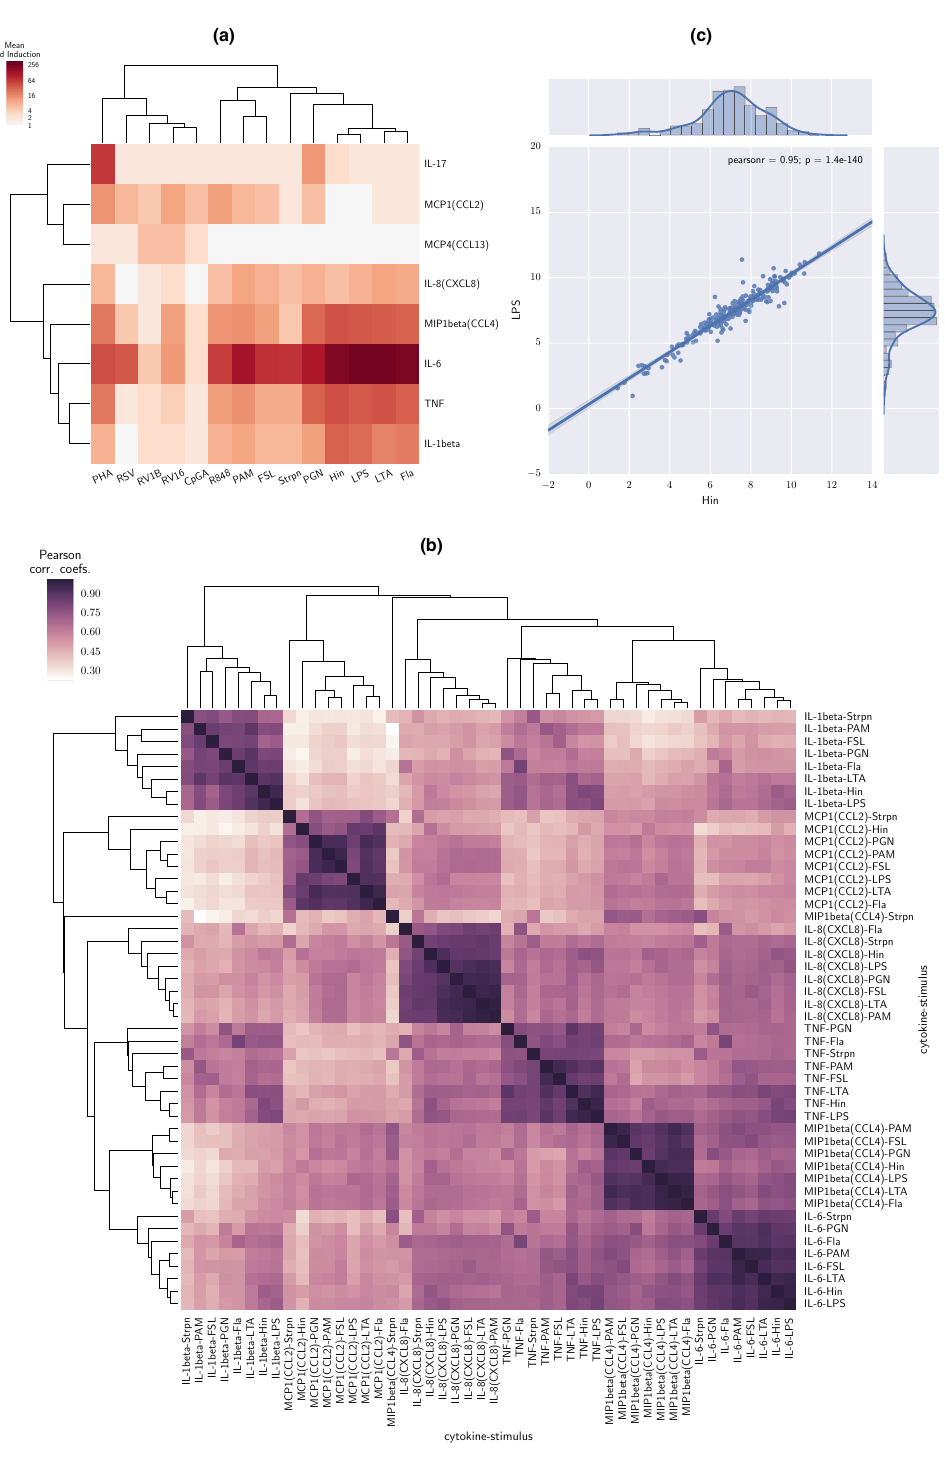
Figure 3. Hierarchical clustering for pro-inflammatory cytokine data. ( a ) HC with heatmap on pro- inflammatory cytokine responses to all stimuli. ( b ) Pairwise Pearson correlation coefficients of production of pro-inflammatory cytokines in response to bacterial ligands. MCP4 and IL-17 were weakly induced and so are excluded from this panel. ( c ) Scatter plot with IL-6 responses to LPS versus IL-6 responses to Hin, and Pearson correlation coefficient between LPS and Hin. This figure was generated using seaborn package in Python (version 3.8, https:// www. python.